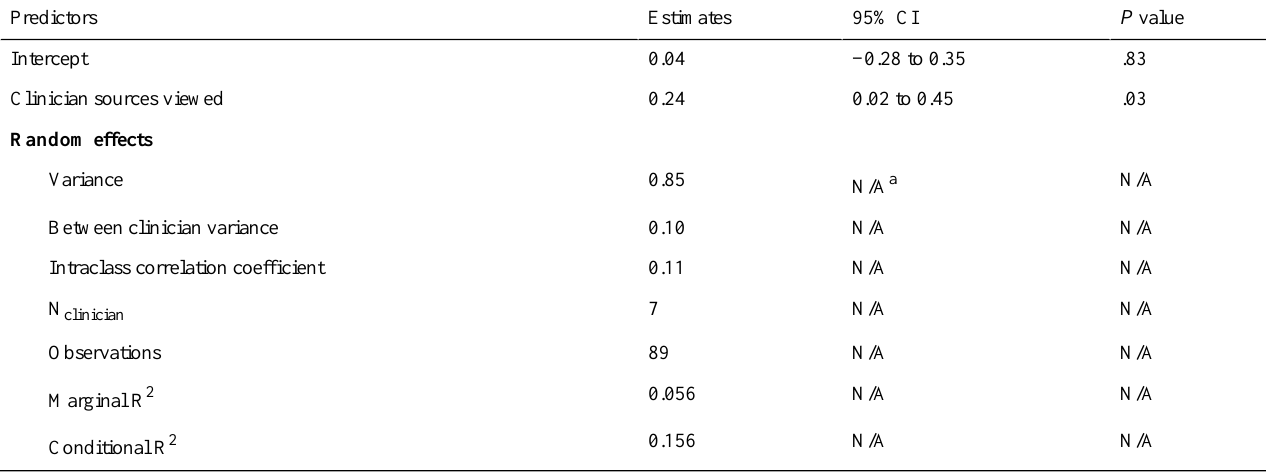
Table 4. Clinician self-evaluated chart sources predicting clinician self-evaluated actions